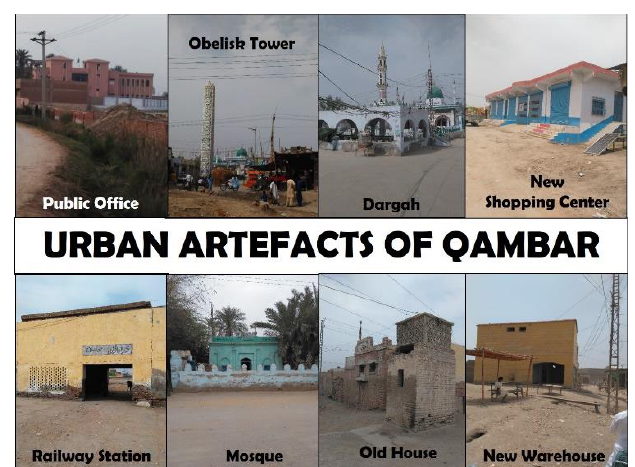
Fig. 16 . Analysis of urban artefacts in public and private realm of Qambar